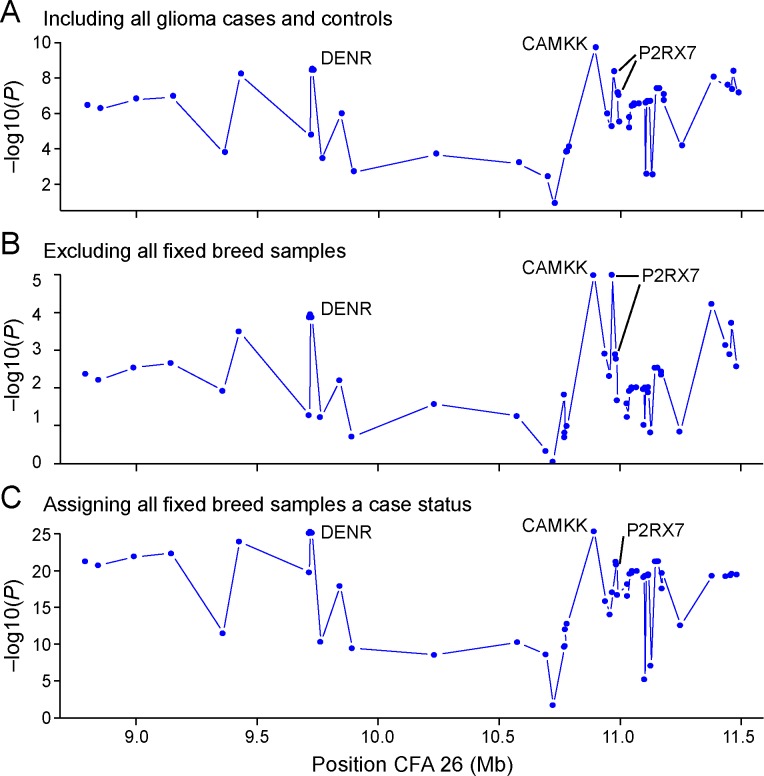
Fine-mapping of candidate SNVs shows the strongest association within the CAMKK2 gene.Genotyping of 56 candidate SNVs showed the strongest association within an intron of CAMKK2 for three tests: Including all glioma cases and controls (A), excluding all fixed breed samples (B), and assigning all fixed breed samples a status as cases (C). Second strongest association was seen in an intron of DENR, and in the gene P2RX7 where one SNV was non-synonymous coding.